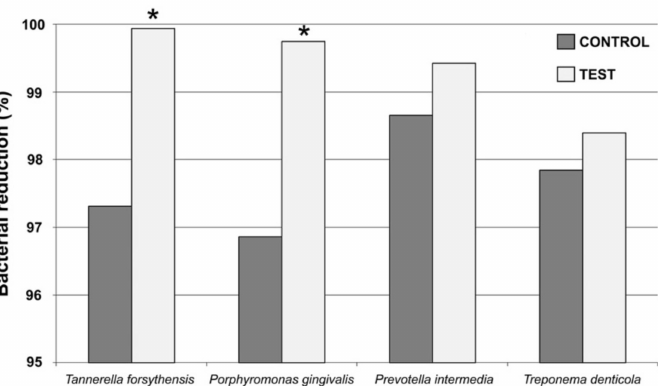
Figure 4. Percentage of bacterial reduction in both groups after one month of the intervention. (* p <